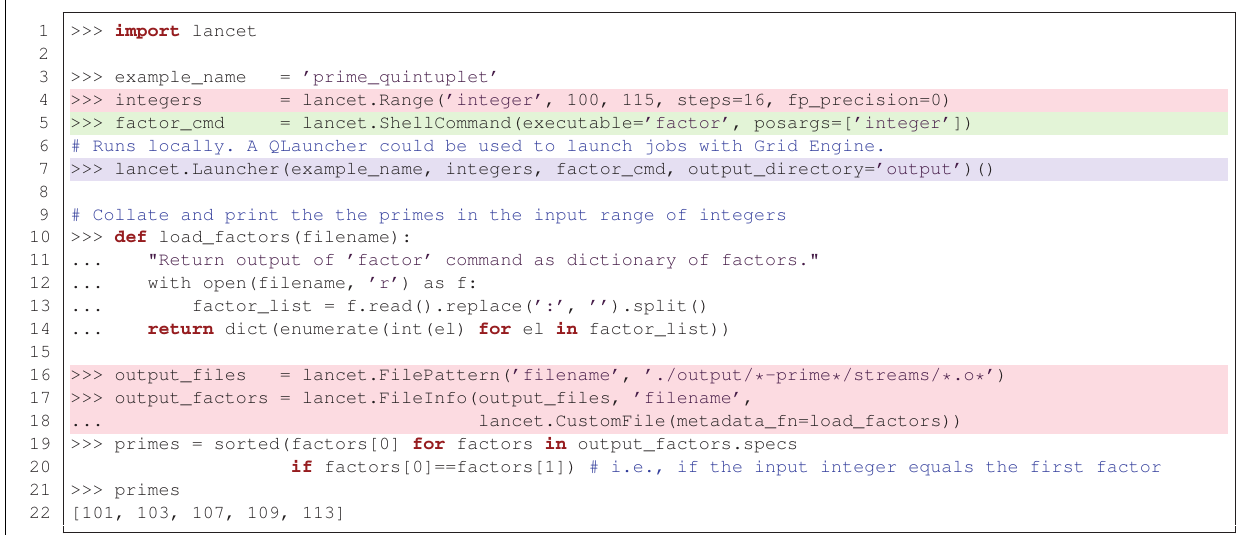
integers with the factor command, with no other dependencies. The five prime numbers found are an example of a prime quintuplet, the closest admissible constellation of five consecutive prime